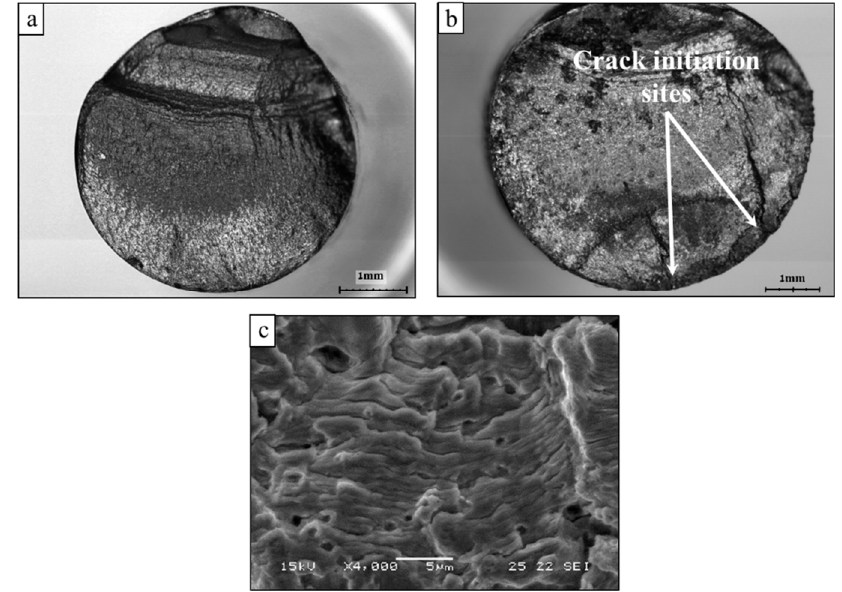
Figure 9. Fractography analysis of additively manufactured ER70S-6 alloy after high cycle fatigue failure ( a ) in air, with 230 MPa load and 1,380,000 cycles; ( b , c ) in 3.5% NaCl solution, with 220 MPa load and 11,987,000 cycles.